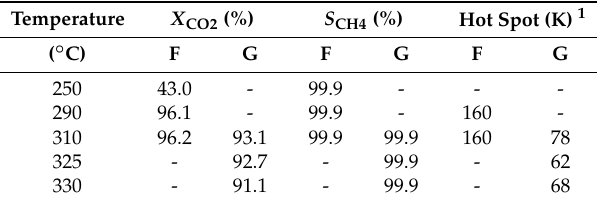
Table 4. CO 2 conversion and methane selectivity on 18Ni/Al 2 O 3 in the large reactor with single bed (run F: GHSV = 8000 h − 1 ) and triple fixed-bed with varying catalyst distribution (run G: GHSV = 10,000 h − 1